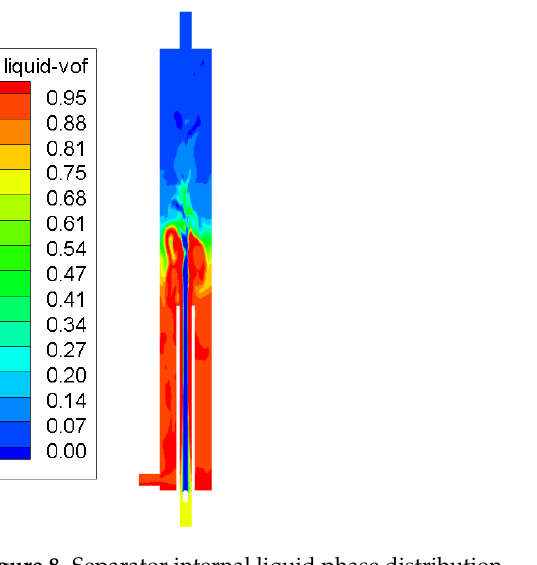
Figure 8. Separator internal liquid phase distribution. To better understand the flow in the inner cylinder of the separator, the outlet posi- tion of the guide vane is assumed to be the cross section of Z = 0 mm in this paper. Five sections are cut up along the inner tube, namely Z = 100 mm, Z = 200 mm, Z = 300 mm, Z = 400 mm, Z = 500 mm. The swirling flow field formed by the guide vane in the inner cylinder is studied by analyzing the flow field at these five positions. As can be seen from Figures 9 and 10, the gas-liquid phase distribution formed by the guide vane in the inner tube is symmetrically distributed along the radial position.